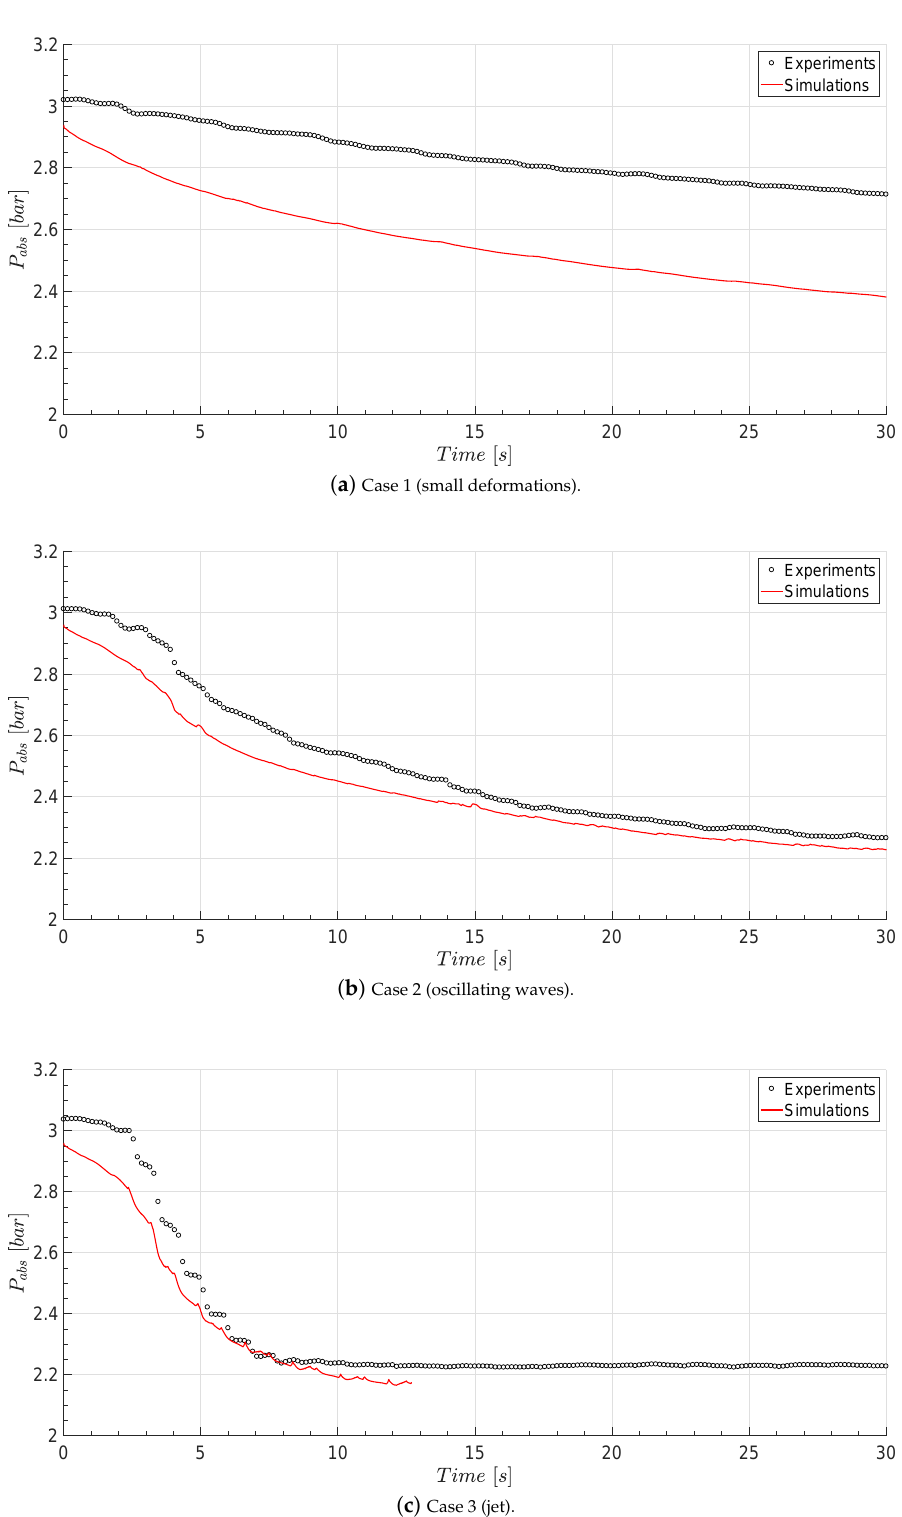
Figure 11. Simulated pressure drop due to the enhanced thermal mixing in a sloshing